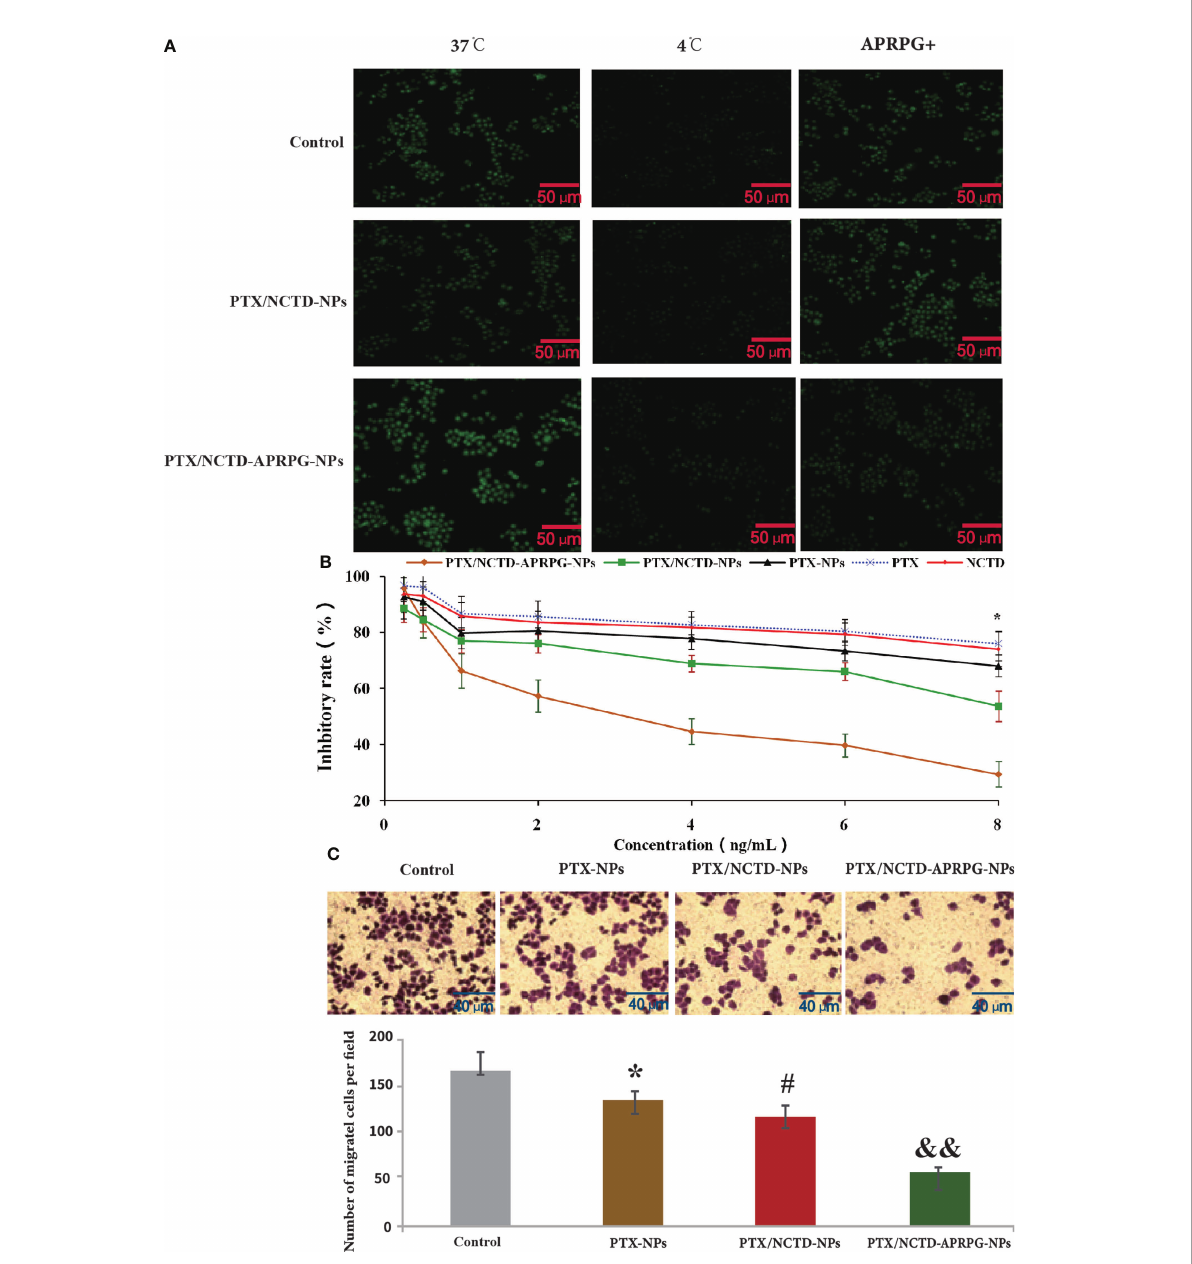
FIGURE 2 In vitro uptake and anti-tumor effects of PTX-NPs, PTX/NCTD-NPs, and PTX/NCTD-APRPG-NPs. HepG2 cells were treated with PTX-NPs, PTX/ NCTD-NPs, or PTX/NCTD-APRPG-NPs, and the proliferation and migration abilities were assayed using MTT and Transwell assays, respectively. A fl uorescence assay was performed to examine the uptake of PTX. (A) Fluorescence microscopic images showing nanoparticle uptake in HepG2 cells. HepG2 cells were incubated with COU6 (10 mg/ml) alone, COU6 (10 mg/ml) in combination with nanoparticles (COU6-nano), or COU6-nano modi fi ed with APRPG (APRPG-COU6-nano). After incubation for 2 h and washing three times with PBS buffer, cells were visualized under a fl uorescence microscope. (B) Comparison of the effects of PTX/NCTD-NPs and PTX/NCTD-APRPG-NPs on the proliferation of HepG2 cells. HepG2 cells were treated with PTX/NCTD-APRPG-NPs, PTX/NCTD-NPs, PTX-NPs, PTX, or NCTD, and proliferation was assayed using MTT; * p < 0.001. (C) Effects of PTX-NPs, PTX/NCTD-NPs, and PTX/NCTD-APRPG-NPs on the migration ability of HepG2 cells. HepG2 cells were treated with PTX-NPs, PTX/NCTD-NPs, or PTX/NCTD-APRPG-NPs, and migration ability was examined using Transwell assays. * p < 0.05 vs. control; # p < 0.05 vs. PTX; && p < 0.01 vs.